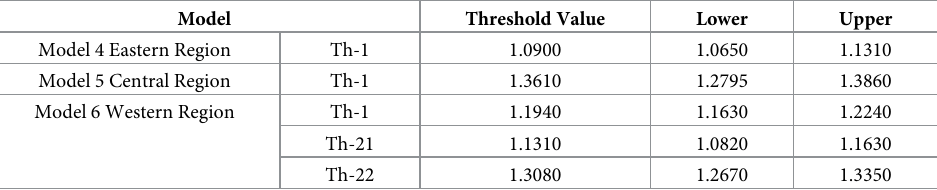
Table 17. Threshold value